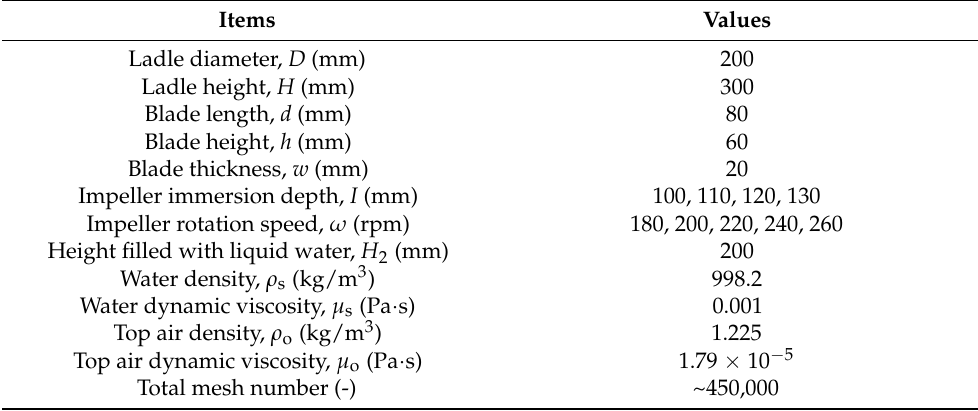
Table 1. The geometrical, physical, and operating parameters used in this study.